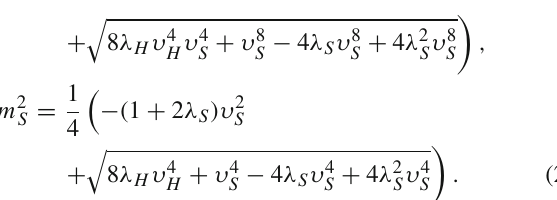
= 0 . 01 (blue) and λ HS